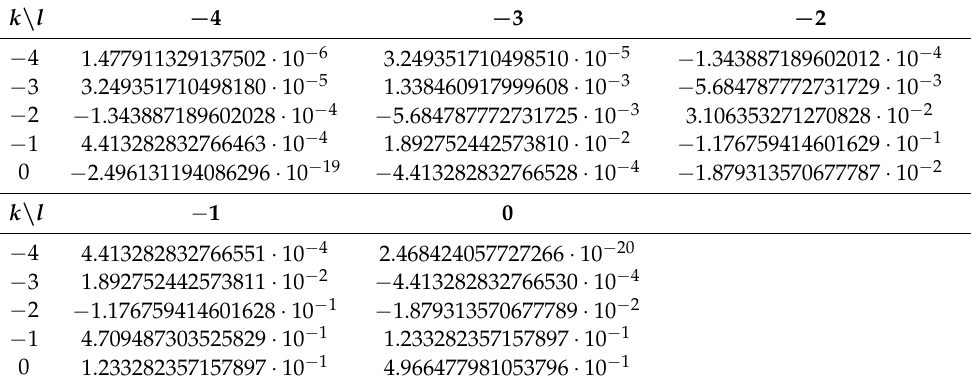
Table 3. The values of the integrals I k , l ( D x Φ I